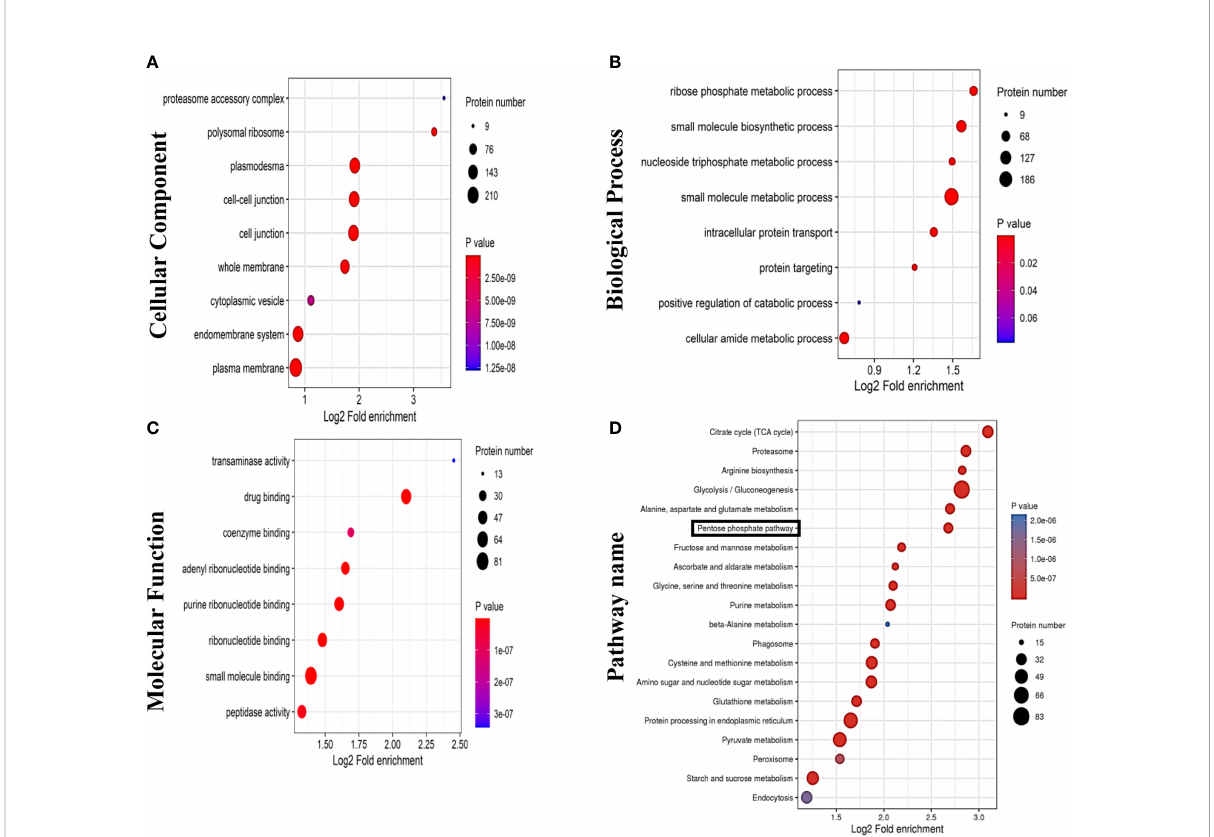
FIGURE 7 Results of proteomics analyses showing GDNPs effects on pentose phosphate pathway (PPP) activity. GO annotation results are listed under three main categories: (A) Biological Process. (B) Molecular Function. (C) Cellular Component. (D) KEGG pathway annotation